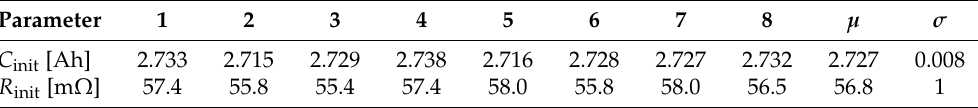
Table 1. Capacities and internal resistances of the 8 cells used in the experiment before aging.